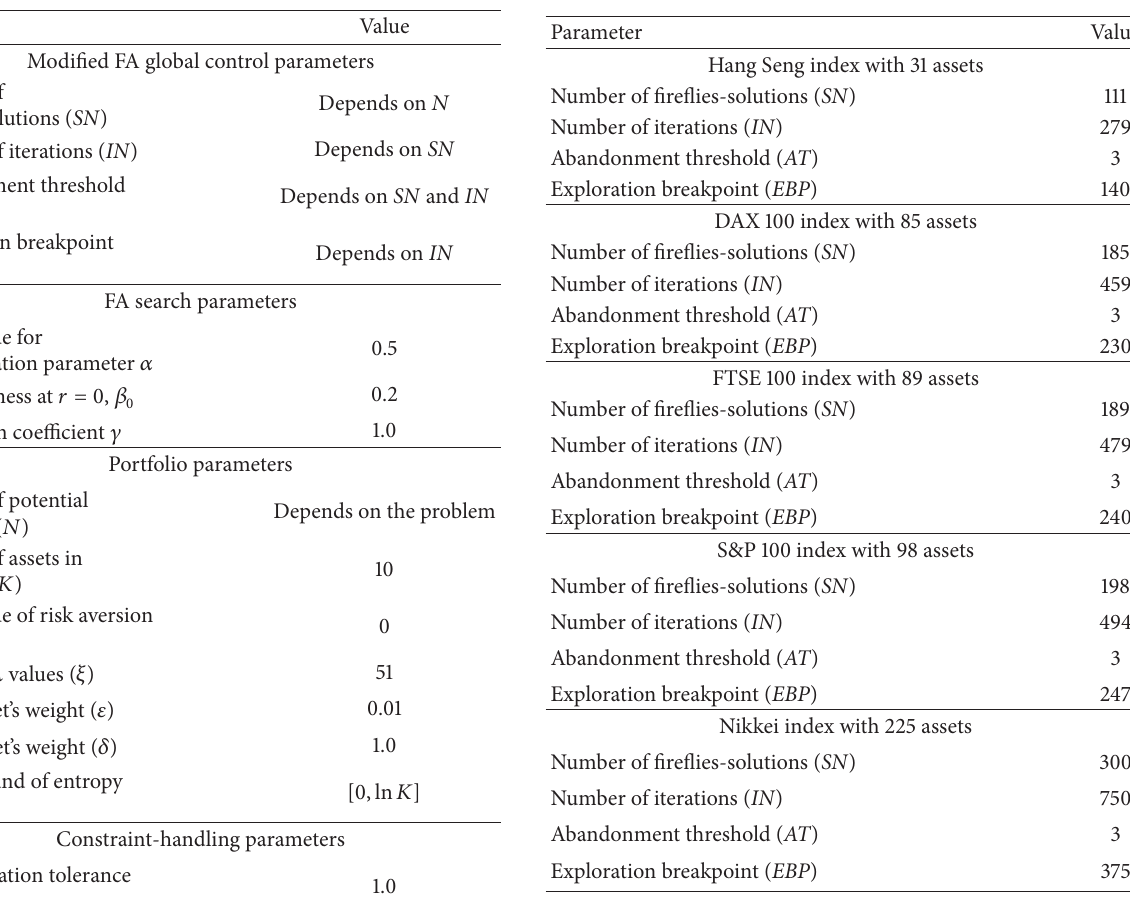
Table 1: Parameters. Table 2: Benchmark specific